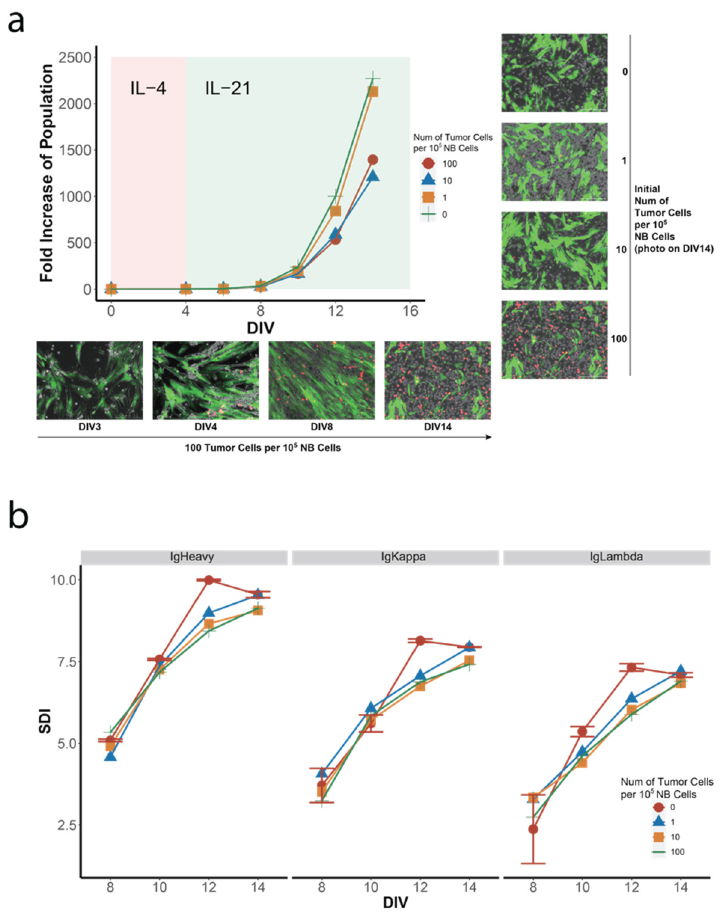
Figure 3. The presence of tumor cells affects both the growth and diversity generation of GC B cells. ( a ) Growth curves and representative microscopic images (merged phase contrast and fluorescence images) of co-cultured human in-vitro hiGC B and Karpas 422 cells. MRC40LB cells exhibited green fluorescence due to stable expression of EGFP; red cells were Karpas 422 cells, stably expressing mCherry, while the normal hiGC B cells were colorless. For the co-culture starting with 100 tumor cells per 10 5 NB cells, images were taken on DIV3, 4, 8, and 14 (bottom panel). For co-cultures starting with 0, 1, 10, and 100 tumor cells per 10 5 NB cells, photos were taken on DIV14 (right panel). ( b ) Shannon diversity index (SDI) curves of co-cultured hiGC B and Karpas 422 cells. The reduction in clonal diversity was most prominent on DIV10 and DIV12. Data of pure hiGC B cells were retrieved from two separate cultures, and error bars represented standard deviation (SD).